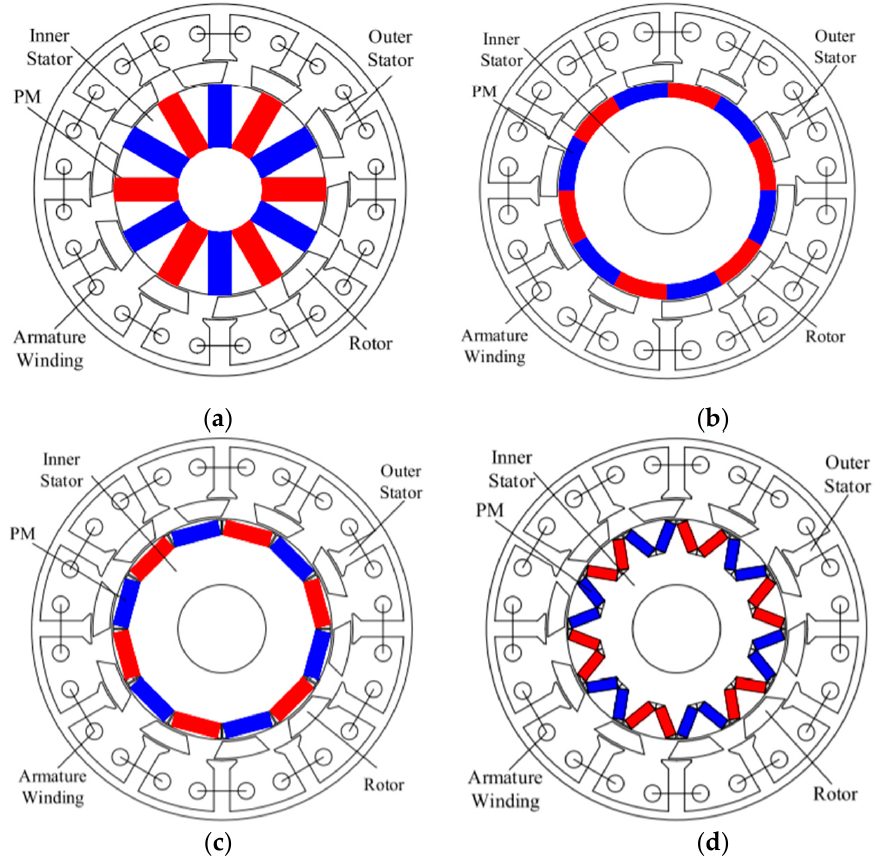
Figure 18. Partitioned stator FMPM (PS-FMPM) machines: ( a ) Partitioned stator FSPM machine; ( b ) Partitioned stator FRPM machine; ( c ) Partitioned stator inserted IPM machine; ( d ) Partitioned stator V-type interior permanent magnet (IPM) machine [48].